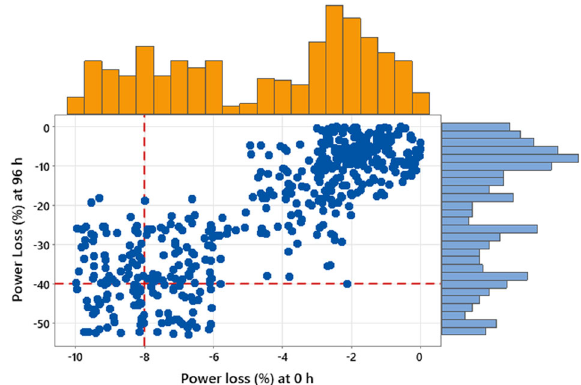
Fig. 4 Marginal plot of the samples taken during the PID test at 0 h and after 96 h. The histogram corresponds to the actual distribution of the data taken during both experiments, PID at 0 h and 96 h.